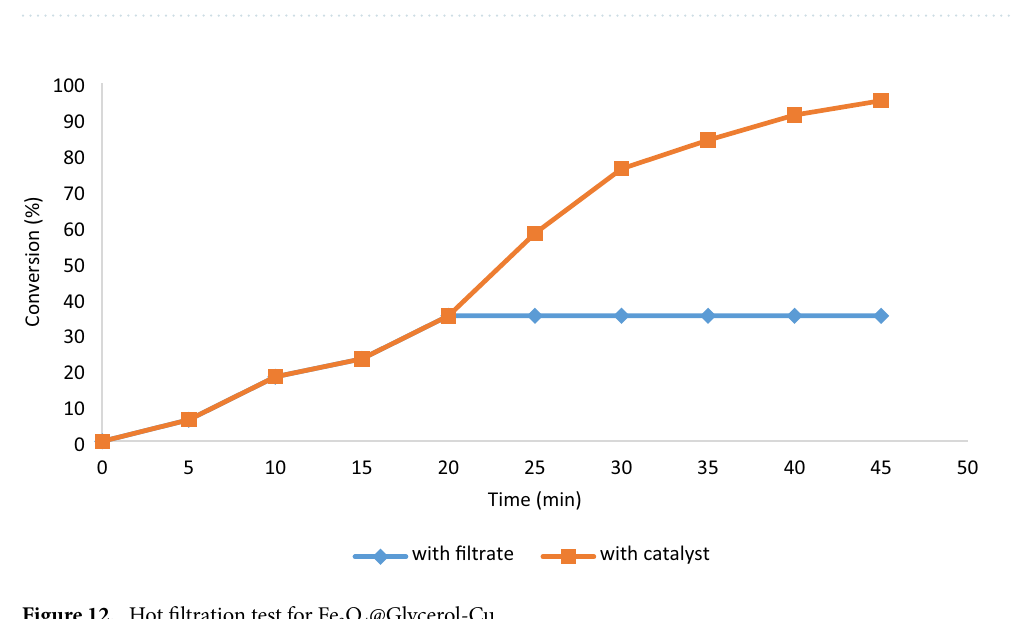
Figure 12. Hot filtration test for Fe 3 O 4